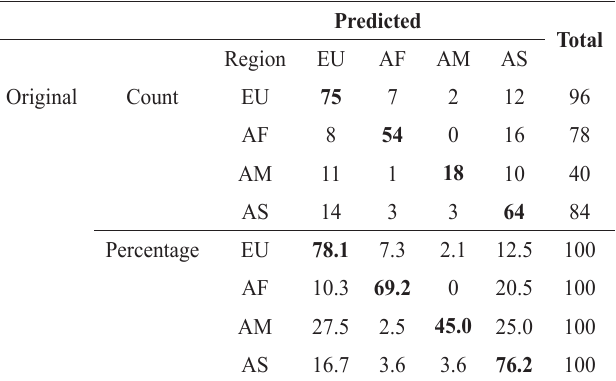
Table 4. Classification results of discriminant analysis.